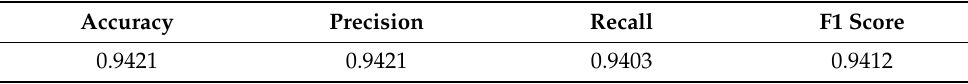
Table 7. Summary of subsets created for labels with strong similarity.